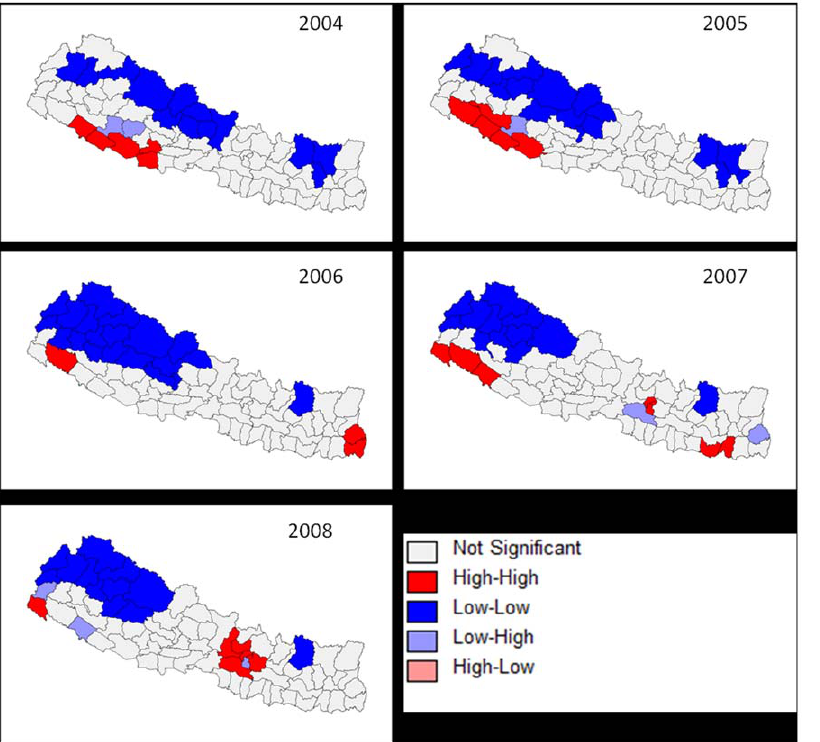
Figure 3. Univariate Local Indicators of Spatial Association (LISA) cluster maps from 2004 to 2008 (A–E) for JE incidence using GeoDa. The cluster map only shows the center of the cluster in color. High-High represents clustering of high JE incidence values, Low-Low represents clustering of low JE incidence values, Low-High represent low values of JE incidence clustered around high values of JE incidence, and High-Low represents high values of JE incidence clustered around low values of JE incidence.